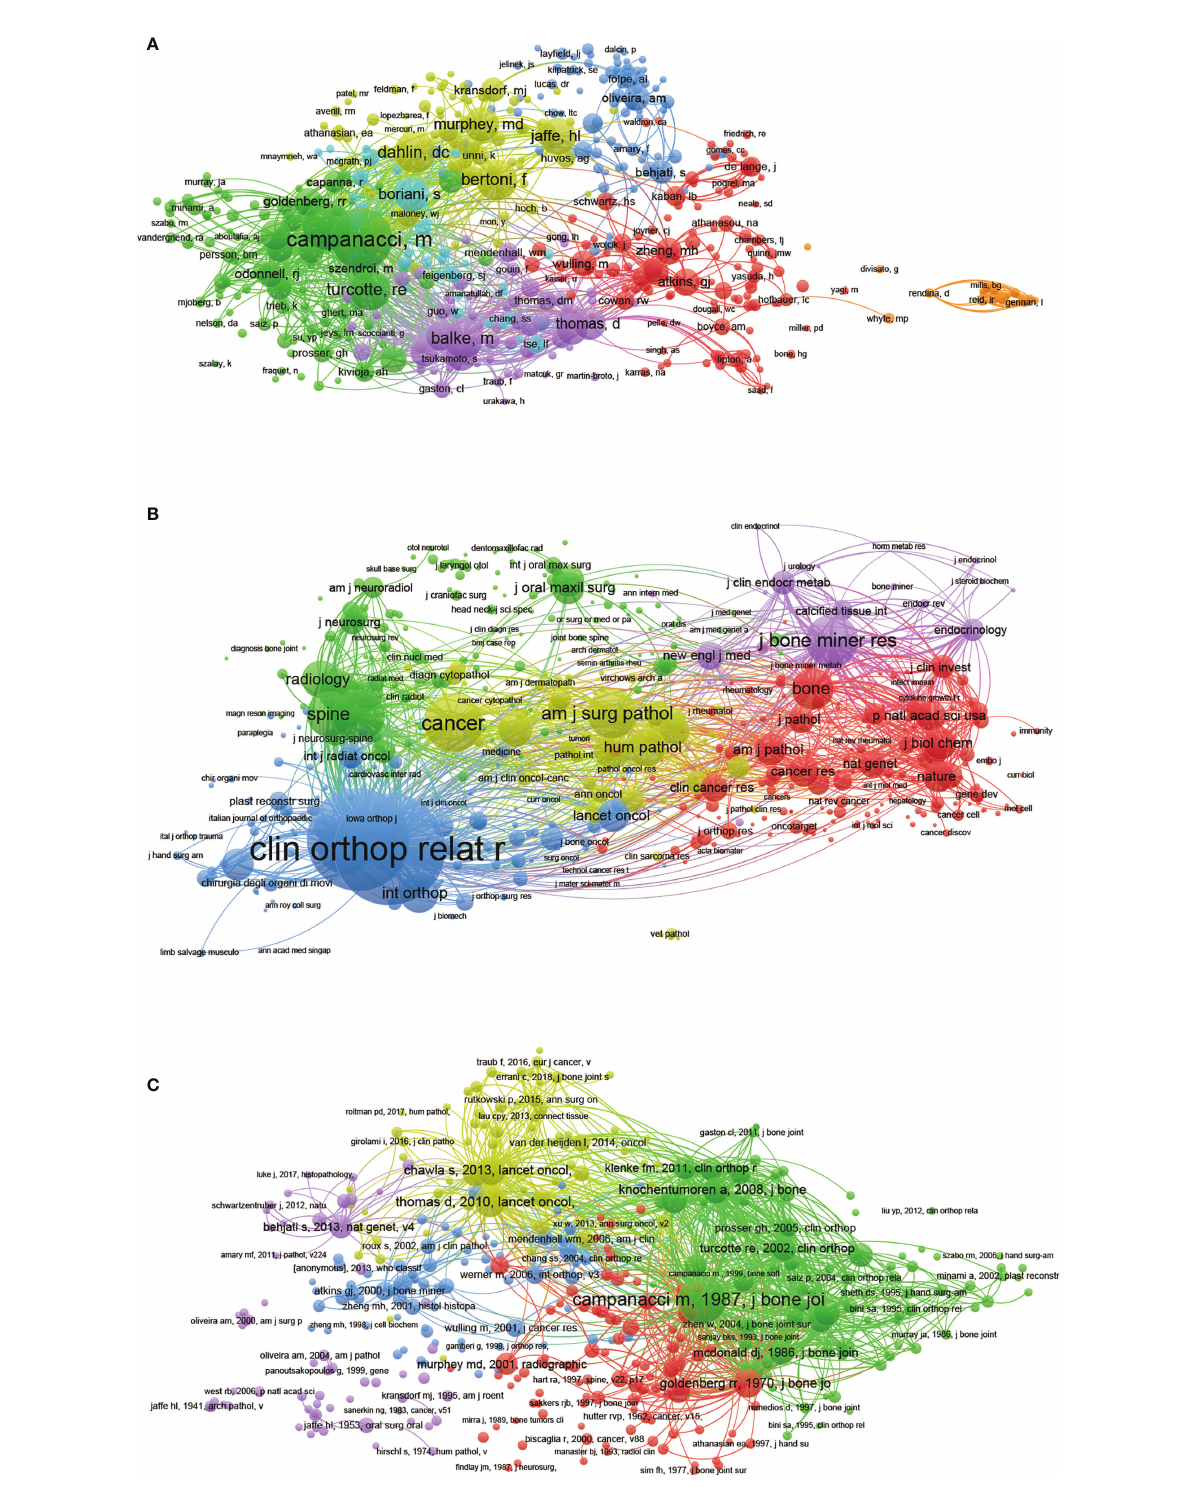
FIGURE 6 Mapping of co-citation related to GCTB. (A) Mapping of the co-cited authors related to this fi eld. (The 555 points with different colors represent the 555 identi fi ed authors.) (B) Mapping of the co-cited journals related to this fi eld. (The 573 points with different colors represent the 573 identi fi ed journals.) (C) Mapping of the co-cited references related to this fi eld. (The 382 points with different colors represent the 382 cited references.). The point sizes represent the citation frequency. The line between different points indicates that they were cited in one paper. The shorter the line, the closer the link between two papers. The same color of the points represents the same research area they belong